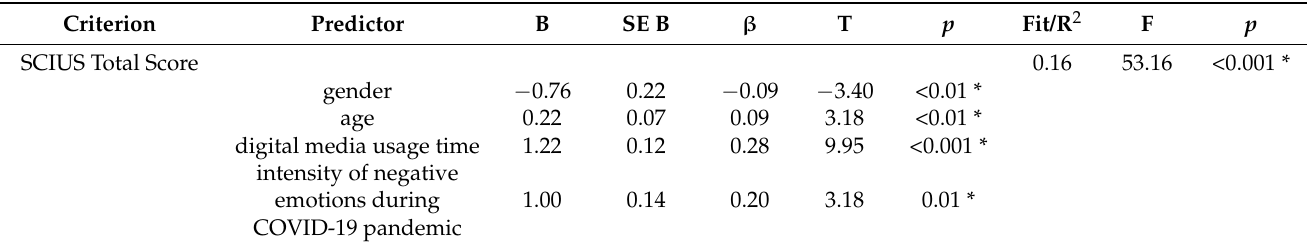
Table 5. Multiple regression results using ICT temperament traits as predictors of